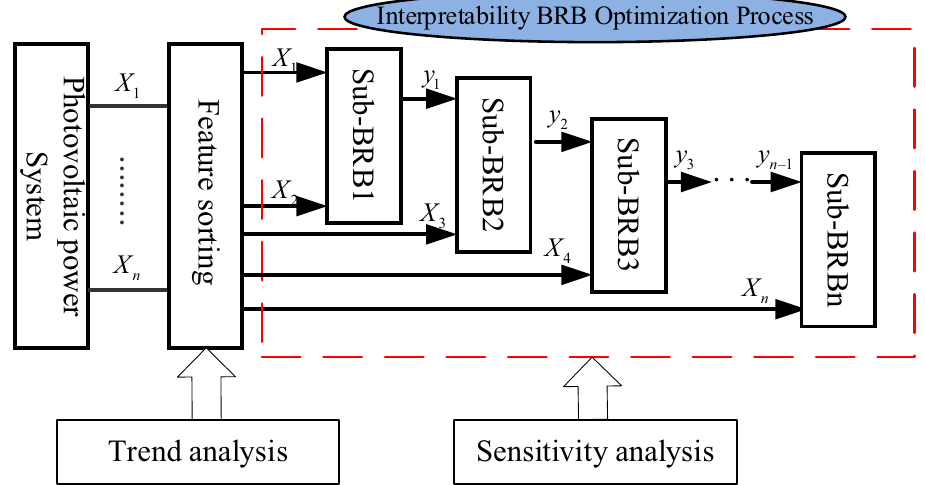
Figure 1. The DBRB-I model based on the PV power generation system.